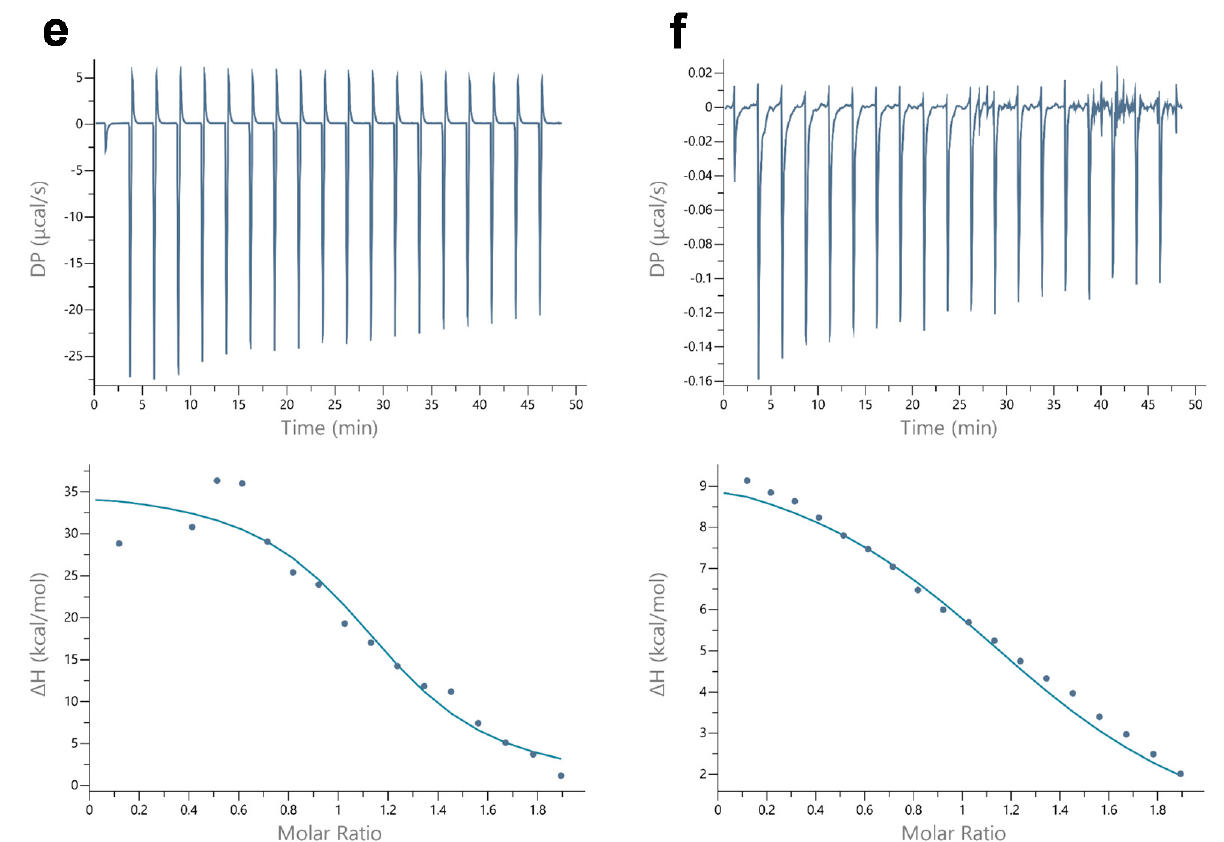
Figure 1. Representative ITC plots of binding of LAC with ( a ) oxy-Mb at pH 7.0, ( b ) deoxy-Mb at pH 7.0, ( c ) oxy-Mb at pH 6.4, ( d ) deoxy-Mb at pH 6.4, ( e ) oxy-Mb at pH 6.0, and ( f ) deoxy-Mb at pH 6.0. Raw data (upper panels) and integrated data (lower panels) represent titration of reactants with time (min) or molar ratios on the x-axis and the energy released or absorbed per injection on the y-axis. The solid lines in the bottom panels represent the best fit of experimental data using a one set of binding sites model provided by the manufacturer’s software (Microcal PEAQ-ITC software). The lower graphs clearly differentiate that at pH 7.0, Mb-LAC binding was predominantly exothermic (downward slope) driven by hydrophilic interactions with large negative enthalpic ( ∆ H) values (details are given in Results and Discussion). In contrast, at acidic pH (pH 6.4 and pH 6.0), the Mb-LAC binding was endothermic (upward slopes) and is mostly favored by hydrophobic interactions and positive ∆ H values. All the ITC experiments were repeated 5 times ( n = 5) to obtain the thermodynamic properties. We have only shown one representative dataset from a single experiment per condition. Statistical analysis was performed with one-tail and two-tail t-test paired two sample for means. All statistical differences in the test data are displayed in superscripts. Table 1. Thermodynamic binding properties of lactate titrated against equine deoxy-Mb and oxy- Mb in ITC experiments in different pH conditions. Dissociation constant ( K d ), association constant ( K a ), the ratio of the receptor concentration, and the dissociation constant are determined by c value. Change in enthalpy ( Δ H°) and change in entropy ( Δ S°) are shown in the table. All the ITC experi- ments were repeated 5 times ( n = 5) to obtain the thermodynamic properties. Statistical analysis was performed using one-way ANOVA and both one-tail and two-tail t -test paired two sample for means for each parameter, separately between oxy-Mb and deoxy-Mb at each pH condition.